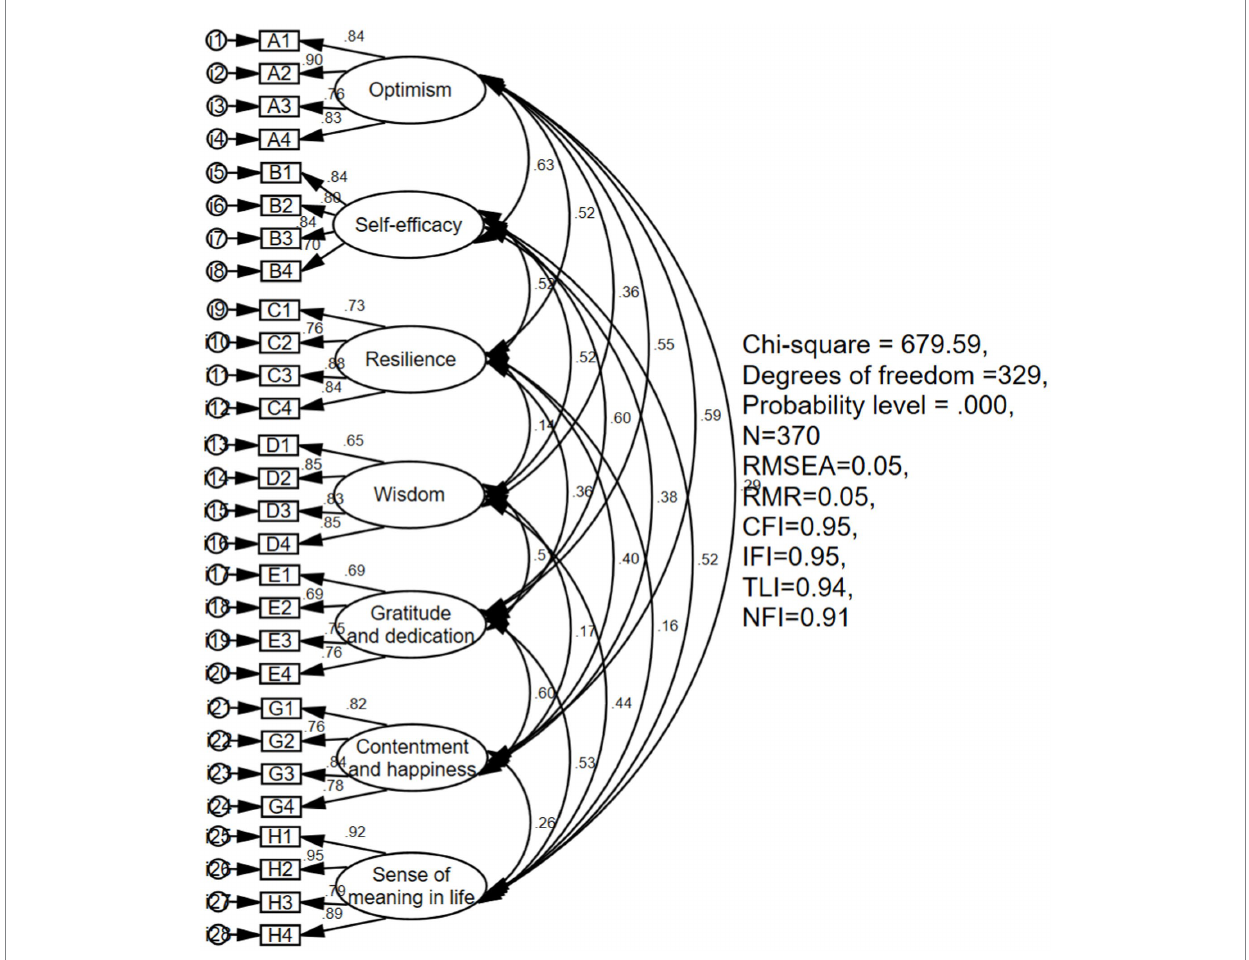
FIGURE 1 Results of SEM for psychological capital of older people. RMSEA, root-mean-square error of approximation; RMR, root mean square residual; CFI, comparative fit index; IFI, incremental fit index; TLI, Tucker-Lewis Index; NFI, normed fit